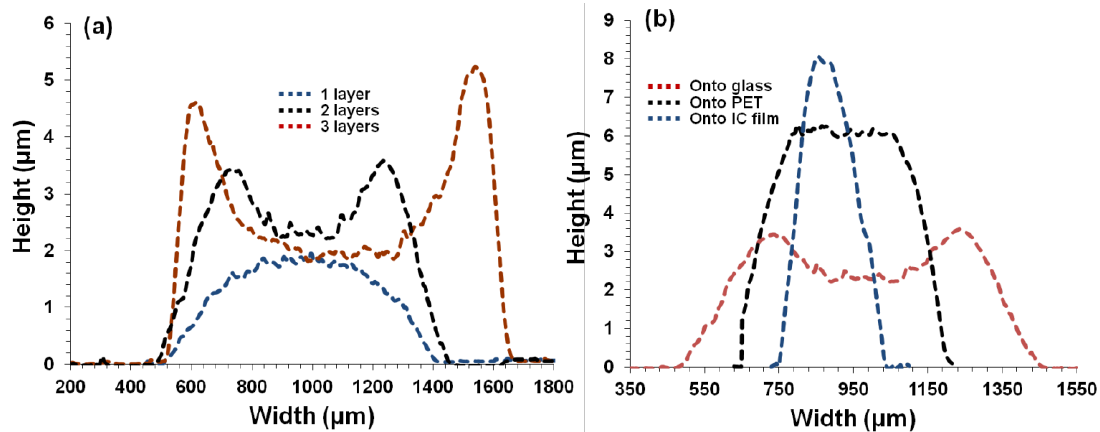
Figure 5. Profilometry curves of printed patterns IC-MWNT ( a ) 1–3 printed layers onto microscope glass substrates and ( b ) 2 printed layers onto glass, PET, and IC films substrates, respectively. Area under the curve represents the cross-sectional area.